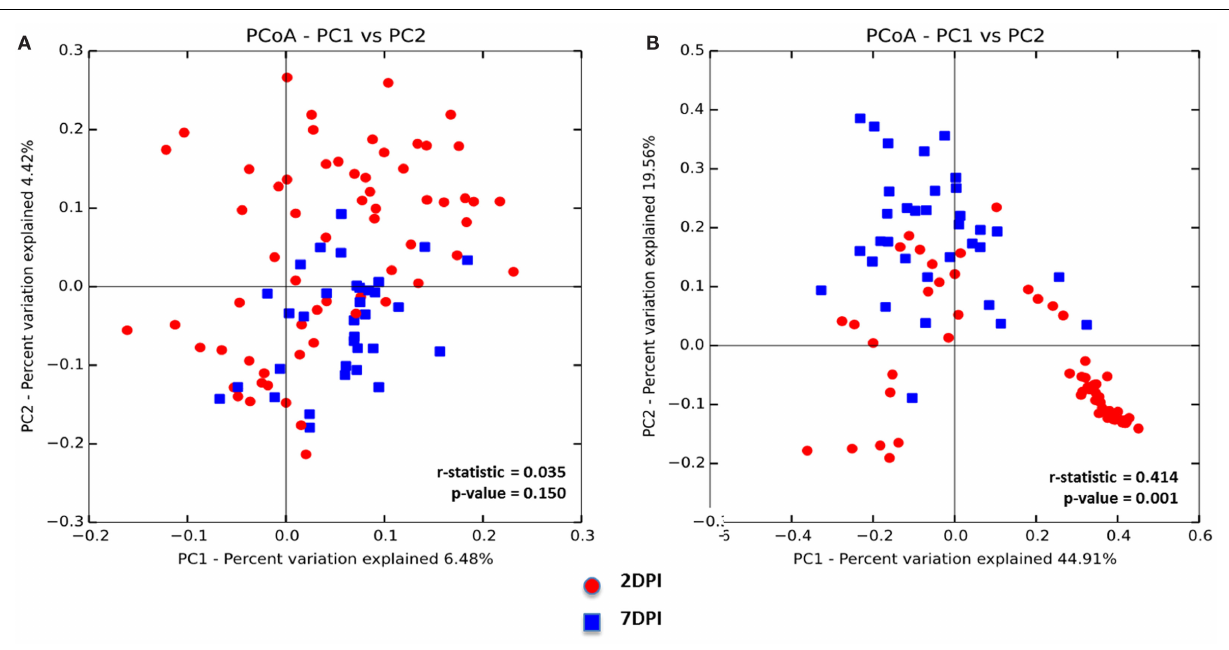
Frontiers in Veterinary Science |